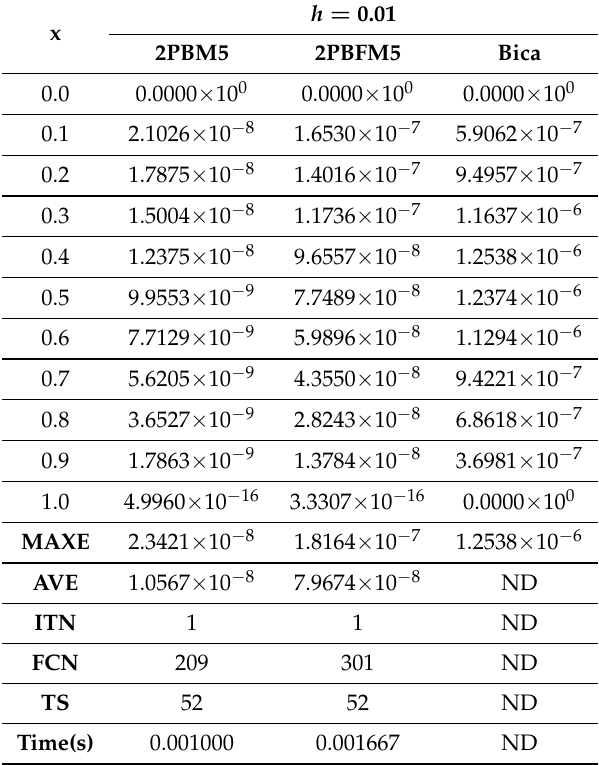
Table 3. The comparison results for Problem 2 at h =